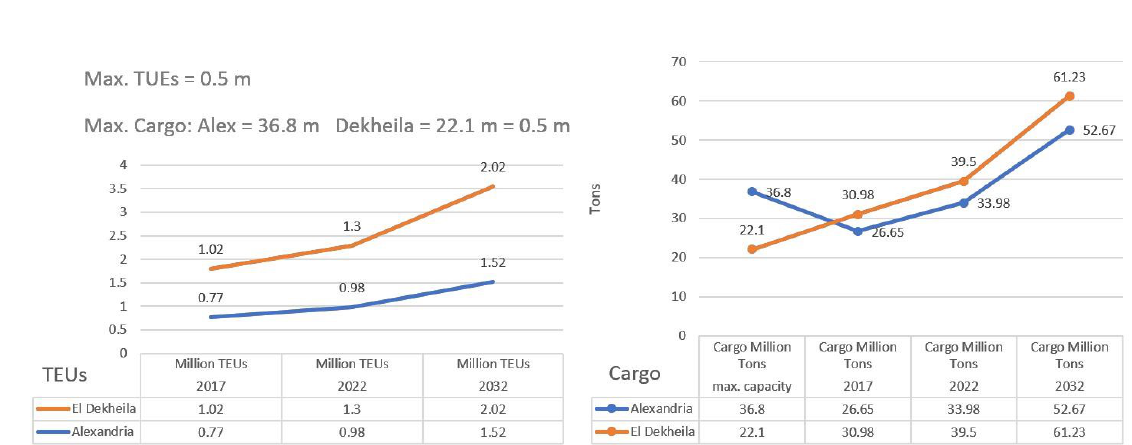
Figure 4. The expected capacity to be achieved at 2017,2022, 2032 for Alexandria and Dekheila ports. This problem confirms the fact that Alexandrian gateways face an incapability of efficiently implementing eco- nomic development and playing its role of leading the city to better future properly. Therefore, Alexandria’s city gates are in need of a complete development plan that addresses the existing problem and provides its future needs.